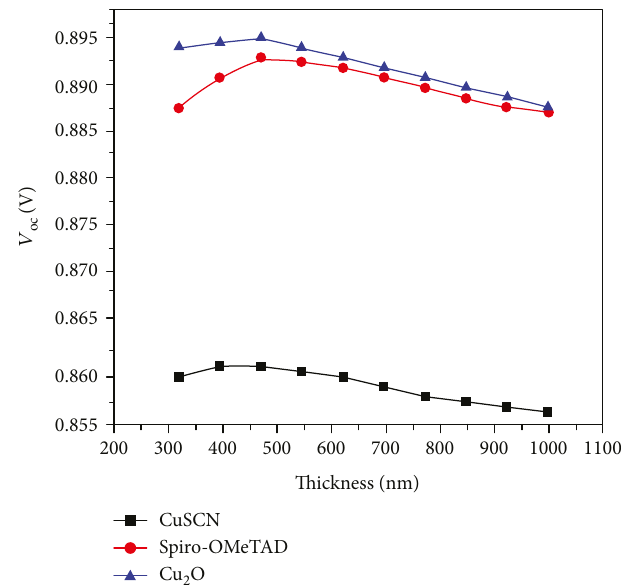
Figure 4: Thickness of the perovskite layer versus open circuit voltage.